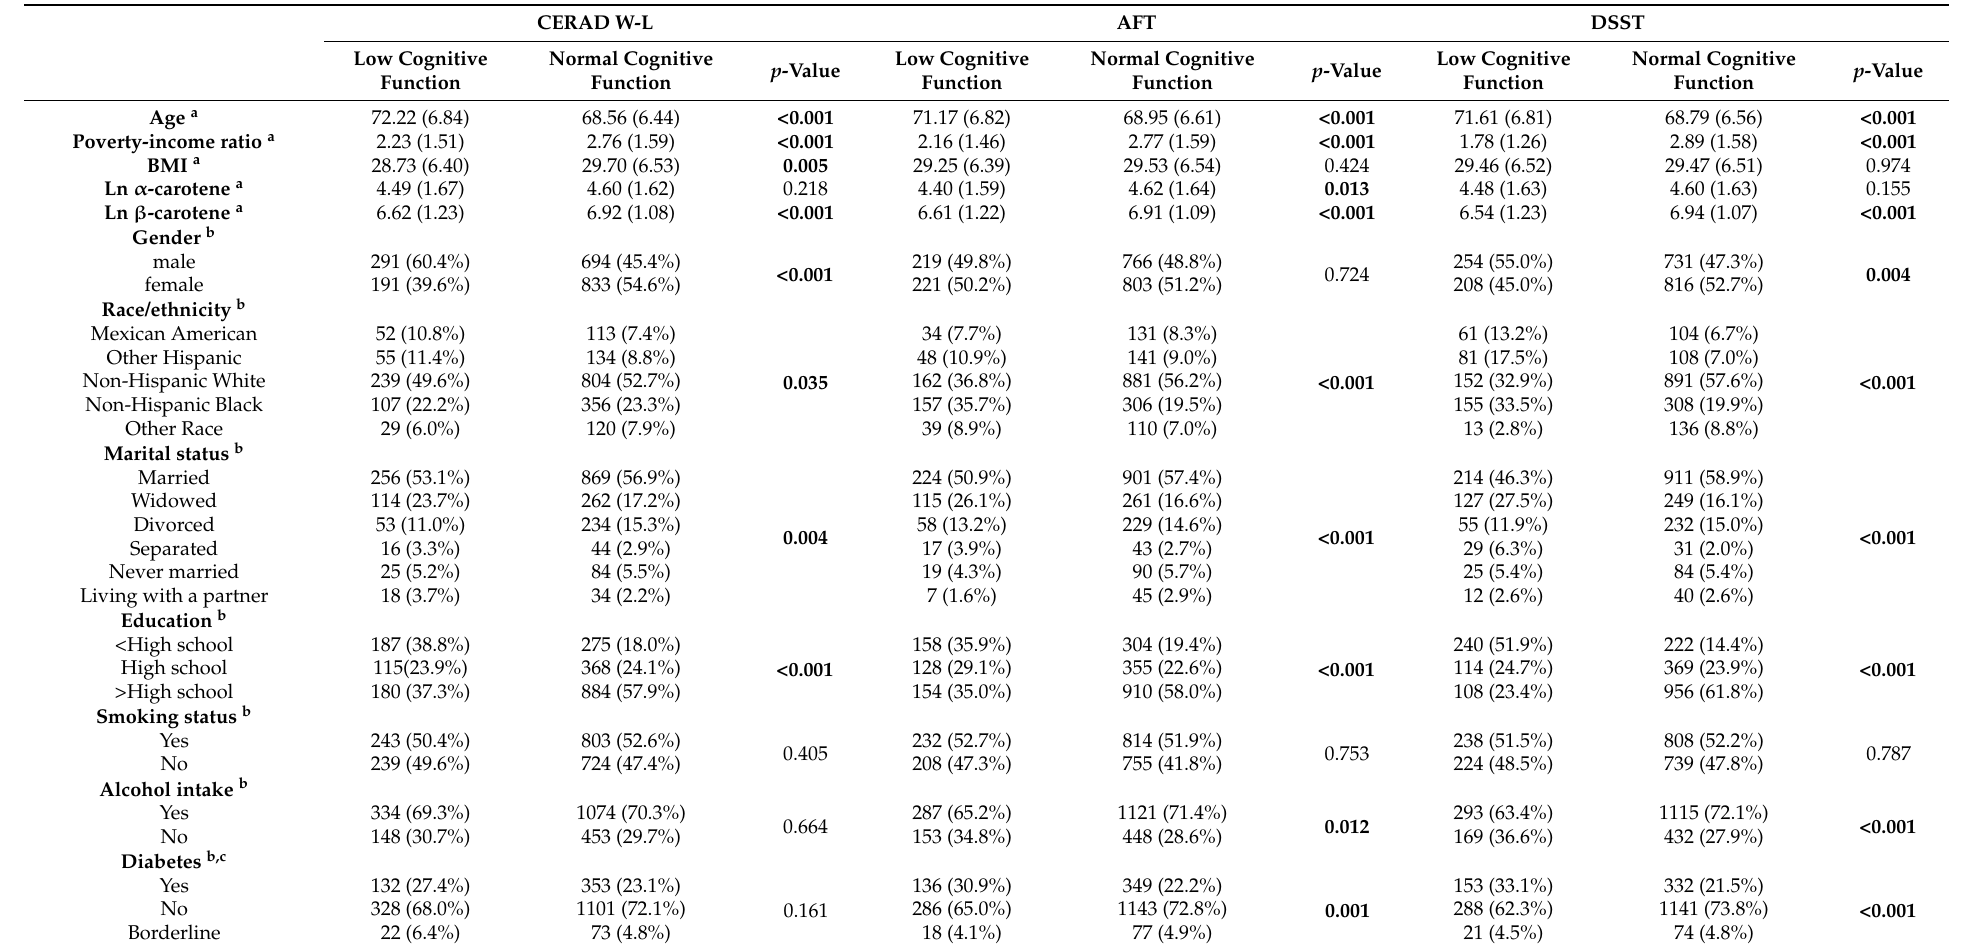
Table 1. Baseline characteristics of participants classified by cognitive function